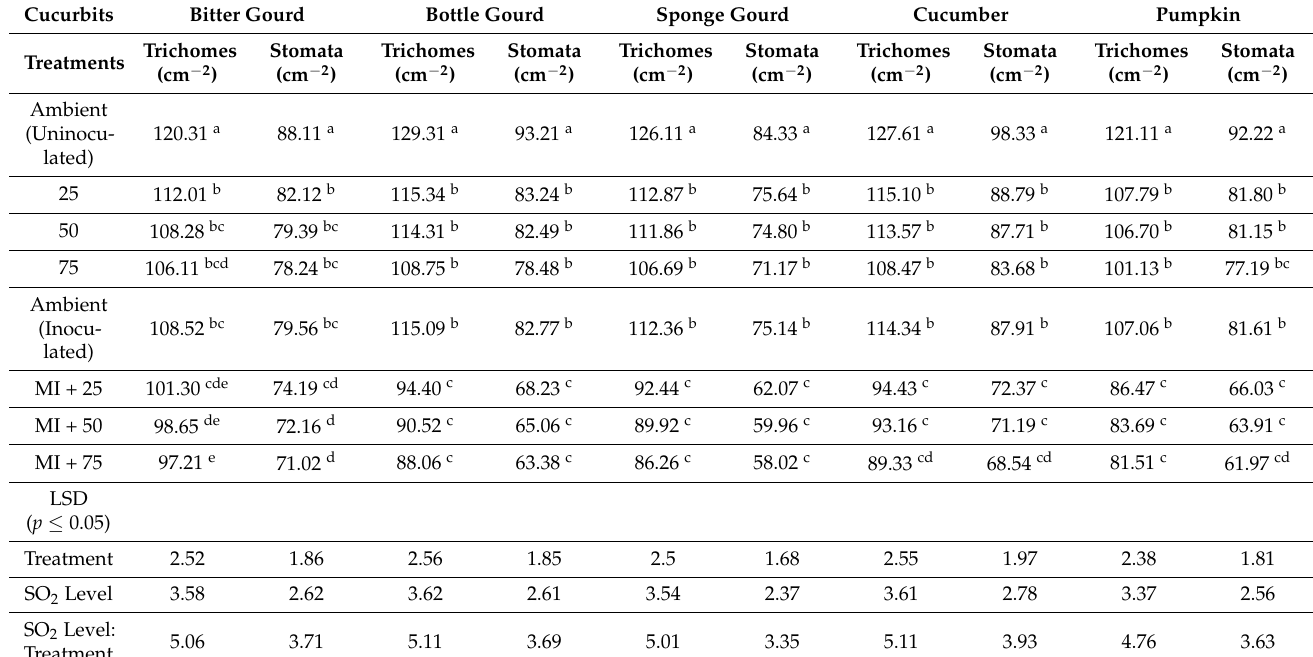
Table 3. Effect of intermittent exposures of SO 2 (ambient, 25, 50, and 75 ppb) and root-knot disease on number of trichomes and stomata in five